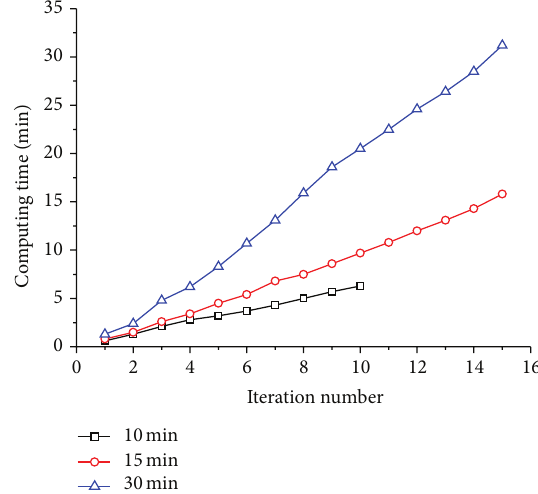
Figure 6: The change relation of objective 𝑍 with the iteration number.